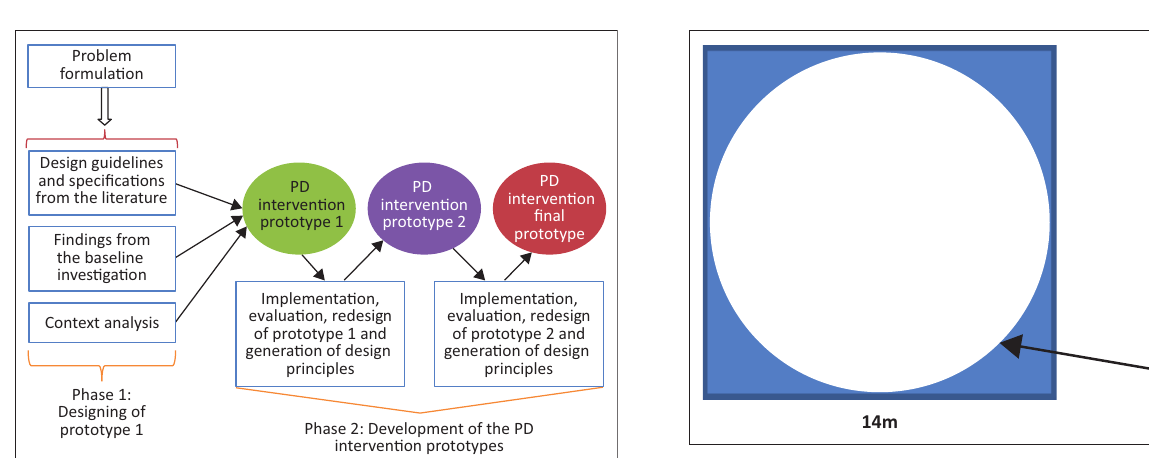
FIGURE 2: Circular patio fitted in a square